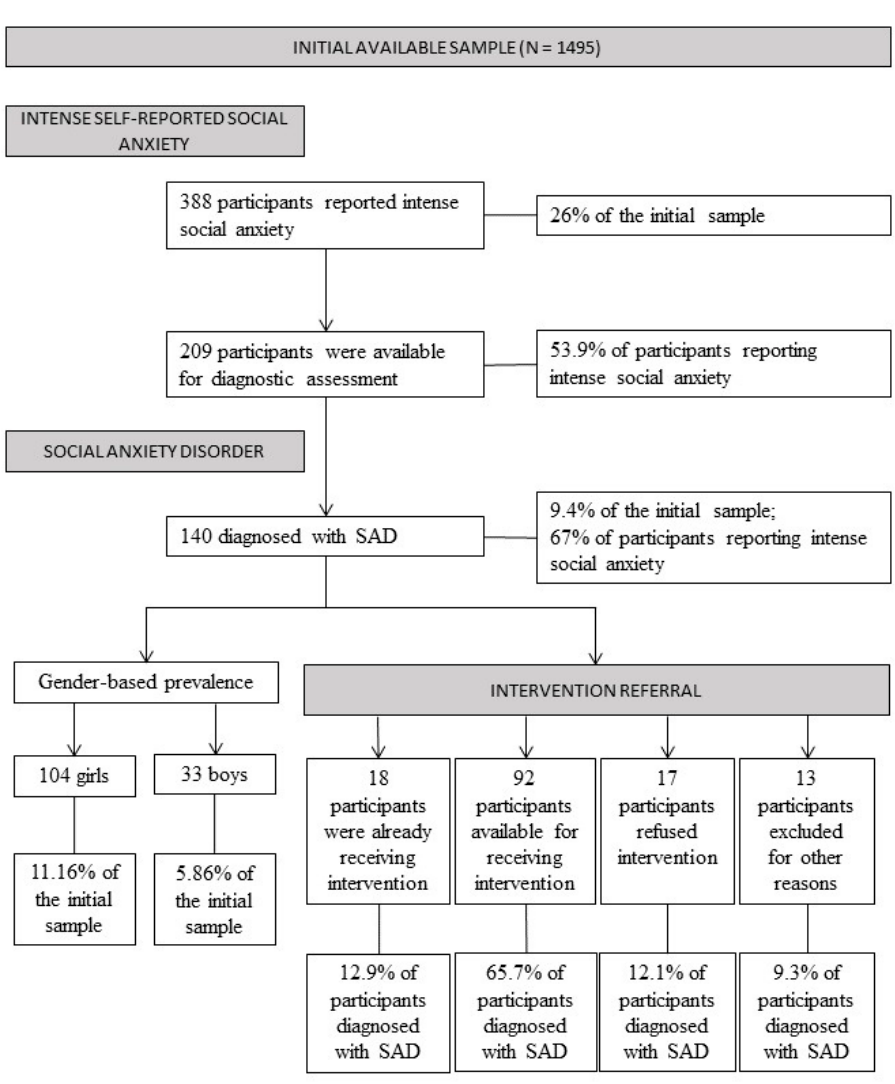
Figure 1. Flowchart of the prevalence estimates found for the screening, diagnostic assessment, and intervention referral phases of the current